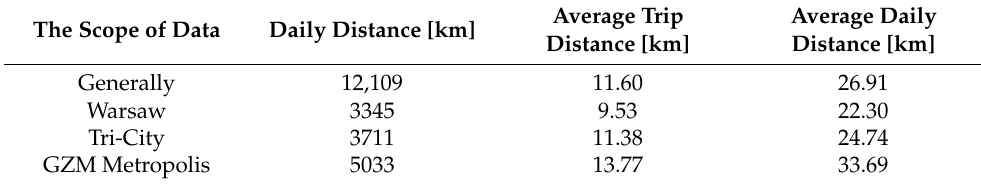
Table 1. Creative class travel distance in urban agglomerations.